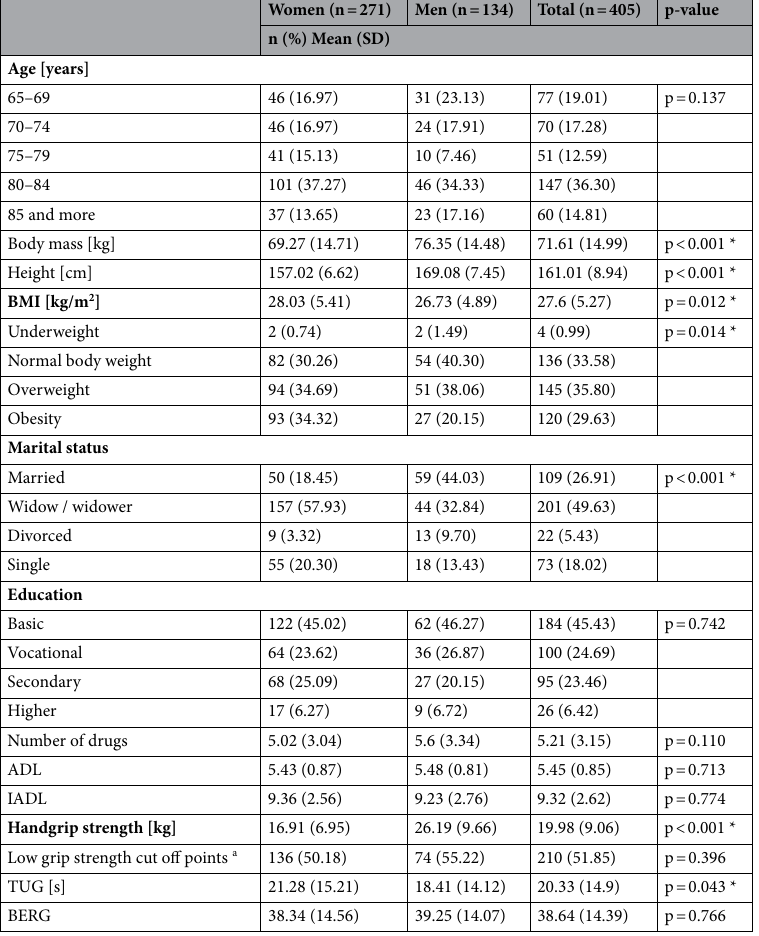
Table 1. Sociodemographic characteristics of the study population. BMI: body mass index, ADL: basic activities of daily living, IADL: instrumental activities of daily living, TUG: Timed up and go test, BERG: Berg Balance Test, n: sample size, SD: standard deviation. * Statistically significant (p < 0.05), a Low grip strength cut- off points for women < 16 kg, cut off points for men < 27